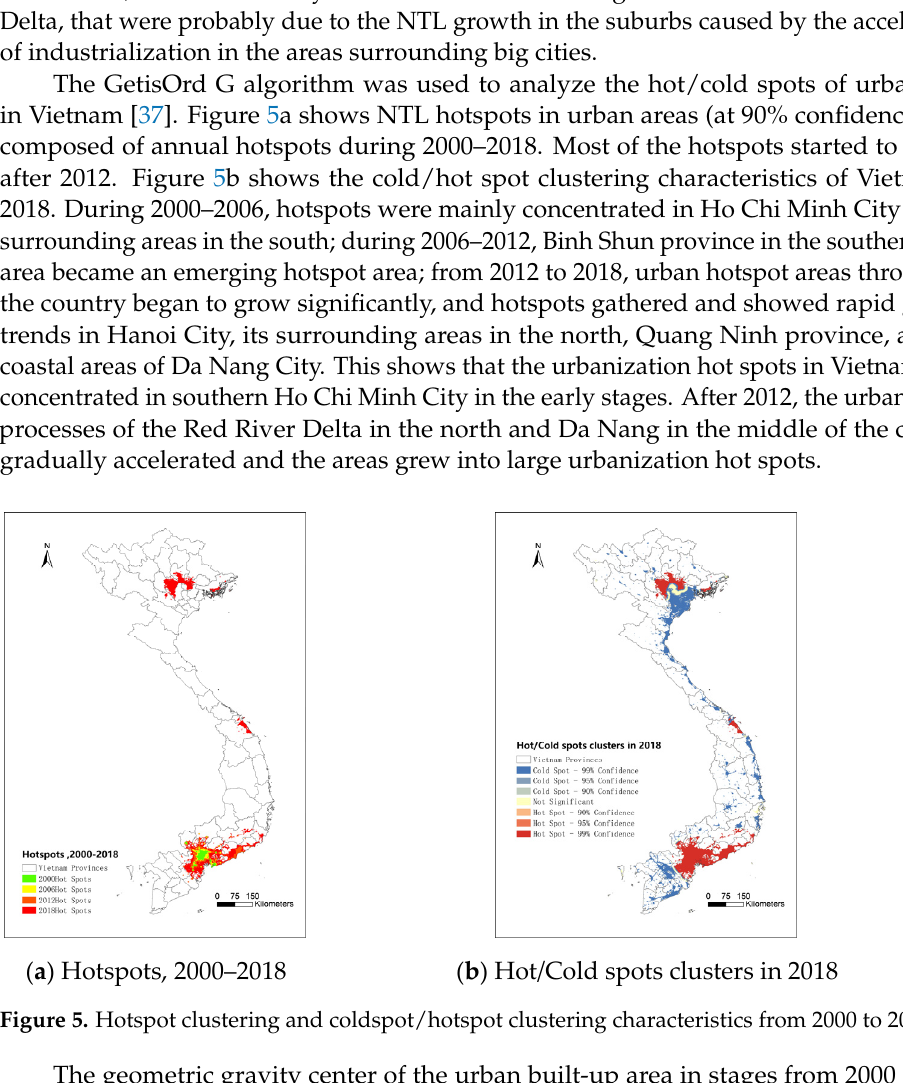
Figure 4. Features of NTL spatial agglomeration.